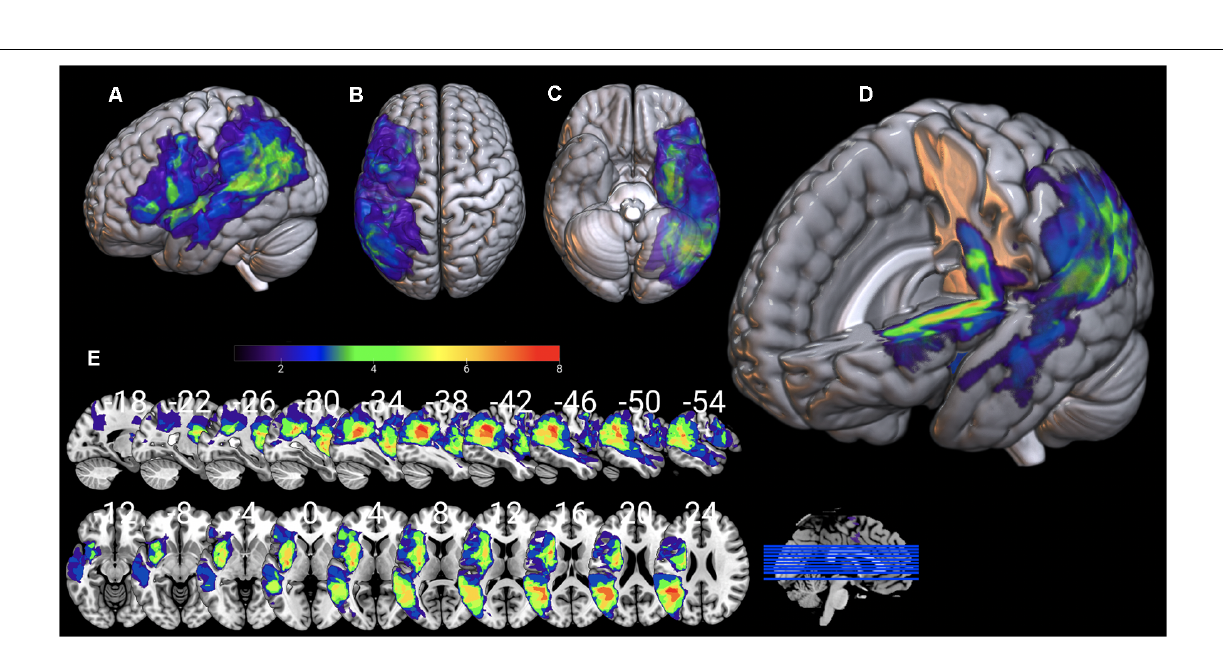
FIGURE 8 | Lesion maps overlay for the AG2 group are shown on 3D views of the standard average brain. The left hemisphere (A) and the dorsal (B) and orbital (C) views of the brain are presented. In (D) part of the left hemisphere is removed. The sagittal and axial serial sections displaying the lesions in MNI stereotaxic coordinates are shown in (E)